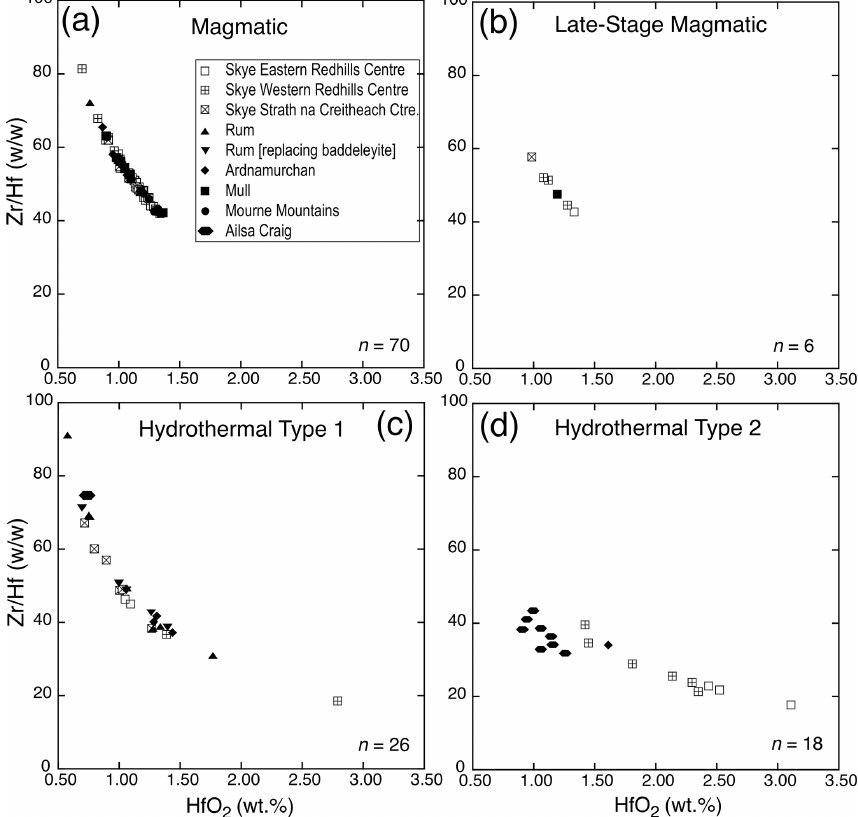
Figure 3. Variation in Zr / Hf w/w versus HfO 2 in the four types of studied zircons: (a) magmatic, (b) late-stage magmatic, (c) hydrothermal type 1, and (d) hydrothermal type 2. The legend shown in (a) applies to all four types where appropriate and is valid for Figs. 4, 5, and 6.